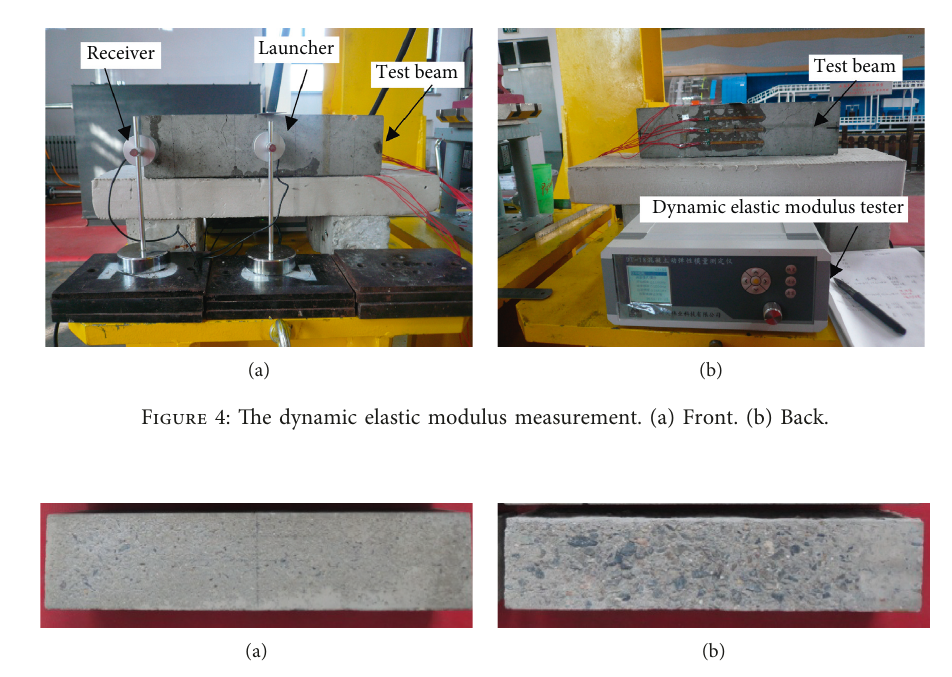
Figure 5: Test beams after 150 freeze-thaw cycles. (a) Test beam after water freezing. (b) Test beam after NaCl freezing. Table 4: Mass of test beams after freezing-thawing (kg).